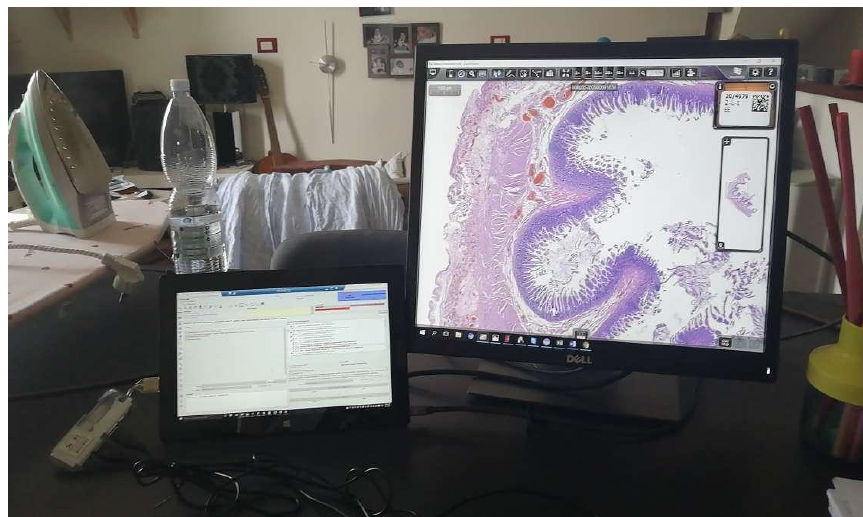
Figure 2. One of the “home-made” working stations used by pathologists for the off-site sign-out and reporting. The smaller monitor (on the left) has a sufficient size and resolution to run the LIS. The right display allows an adequate visualization of the WSI.